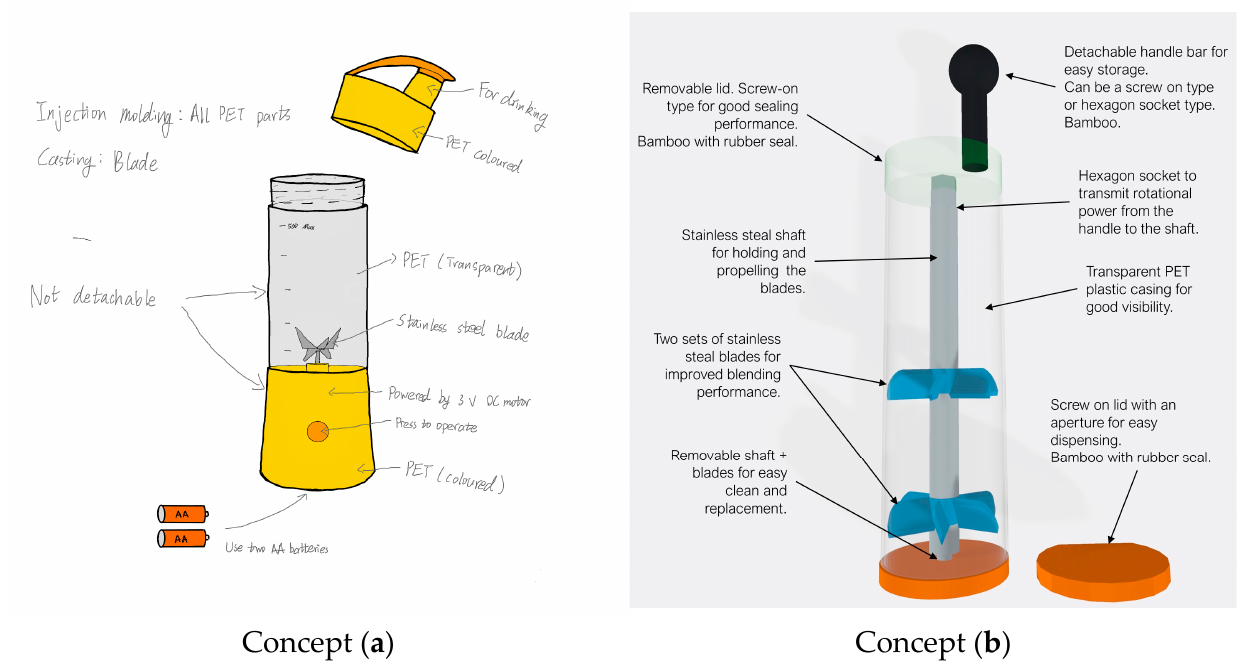
Figure 3. Portable blender concept ( a ) and ( b ). Table 7. Key product design specifications.